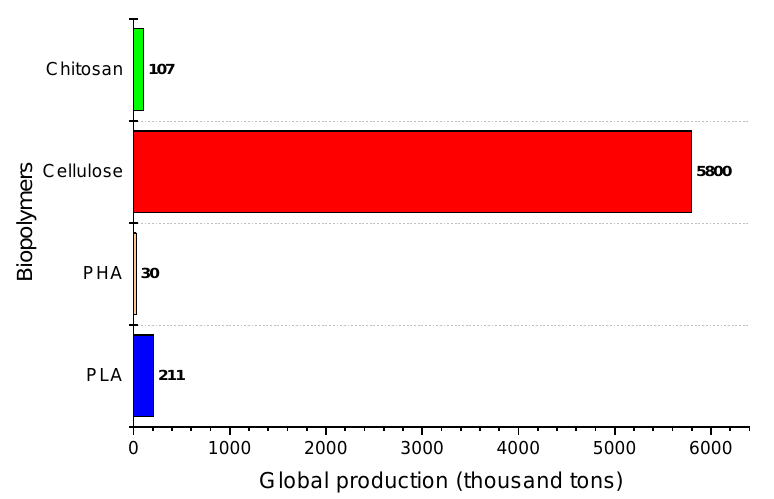
Figure 5. Global production of biopolymers in the year 2020 [91 – 93].